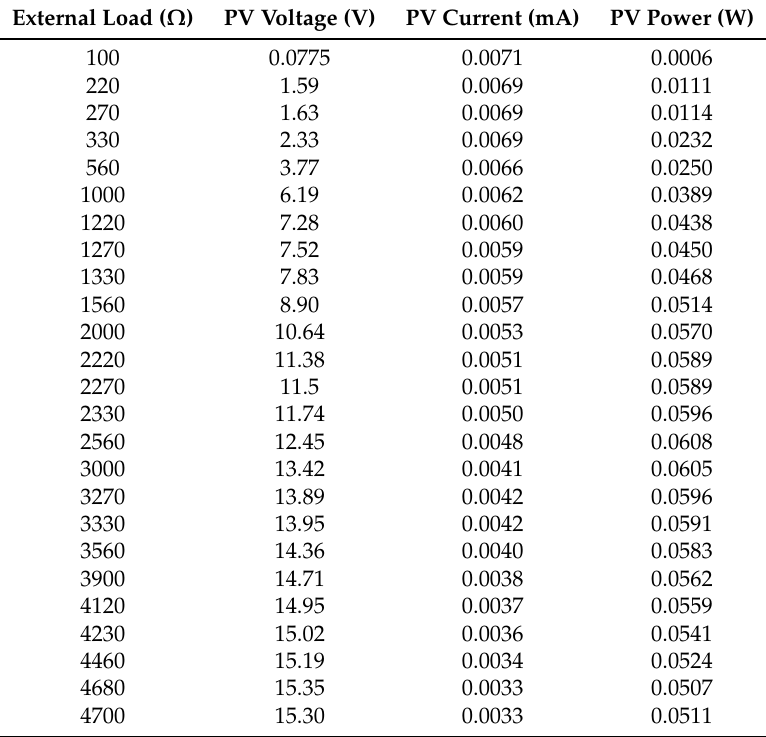
Table A2. Measured values for the low irradiation level.